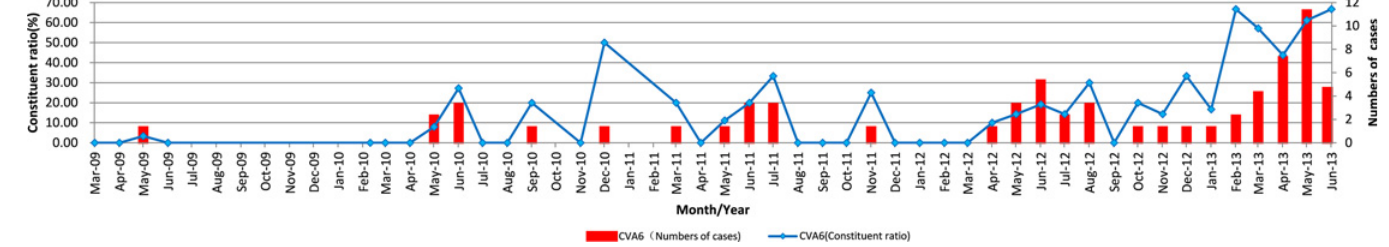
Fig 3. Monthly distribution of CVA6 associated with HFMD during 2009 to June 2013 in Jinan, China.